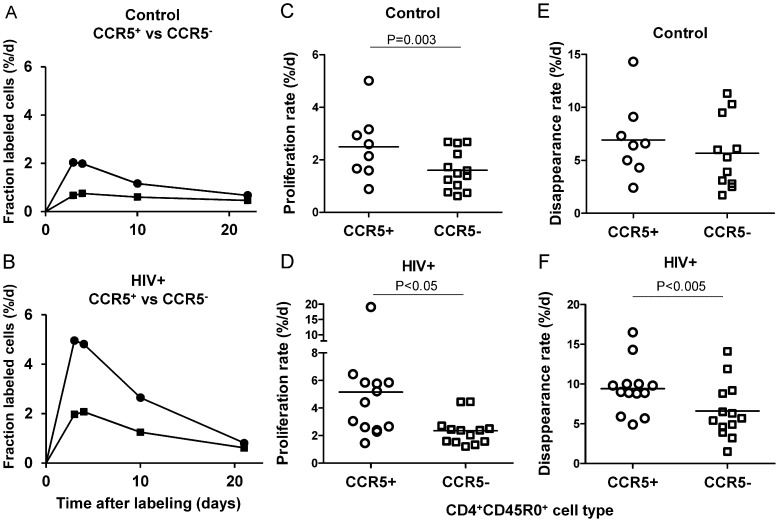
Relationship between CCR5 expression and proliferation, disappearance and phenotype in CD45R0+ CD4+ memory T-cells.(A,B) Deuterium enrichment plots expressed as fraction of labeled CD45R0+ CD4+ memory T-cells from a one-day labeling experiment. Cells are compared according to CCR5 expression: circles, CCR5+; squares, CCR5−. Representative data are shown from one typical control subject (A) and one HIV-positive subject (B). Modeled proliferation (C, D) and disappearance (E, F) rate constants for CD45R0+ memory CD4+ T-cell subsets defined by CCR5 expression in healthy (C,E) and HIV+ (D,F) subjects. Symbols denote cell type: circles, CCR5+; squares, CCR5−; horizontal bar, mean, P values by paired t-test.